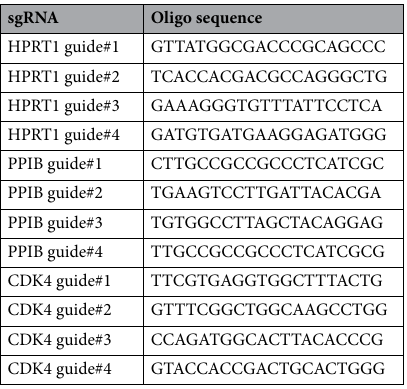
Table 1. sgRNA sequences.